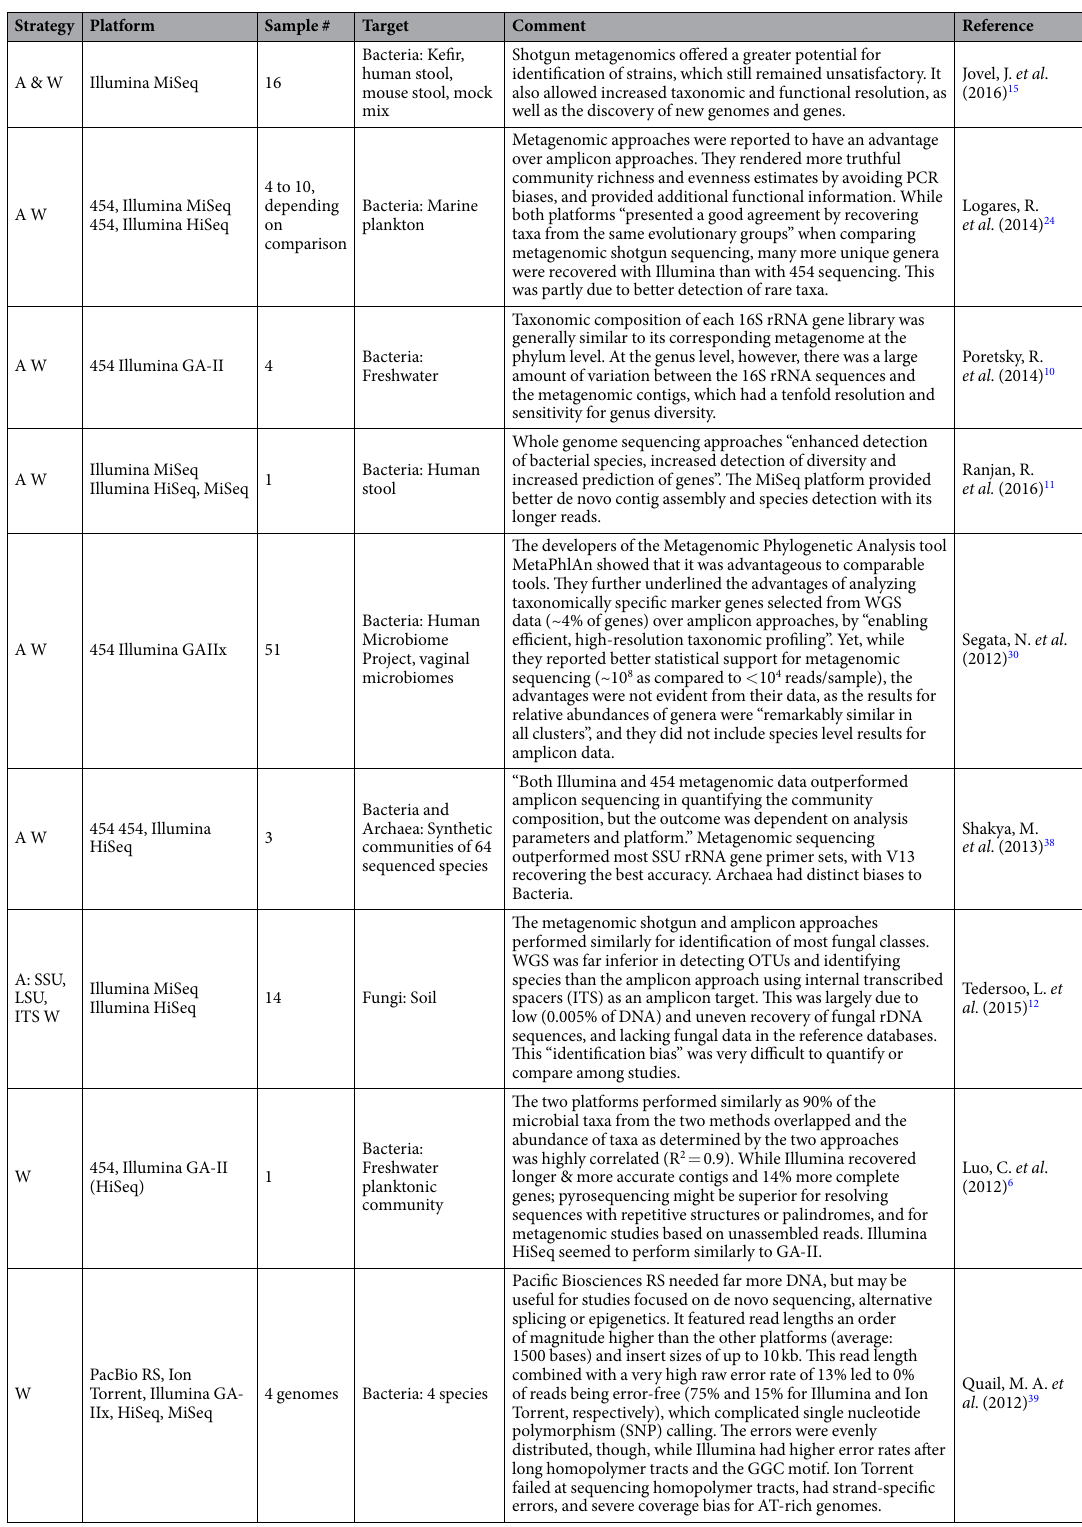
Table 1. Summary of studies comparing different NGS sequencing strategies and sequencing platforms. In the Strategy column abbreviations are A = 16S amplicon, C = clonal amplification, W = WGS shotgun, and W * = WGS where SSU sequences are extracted and